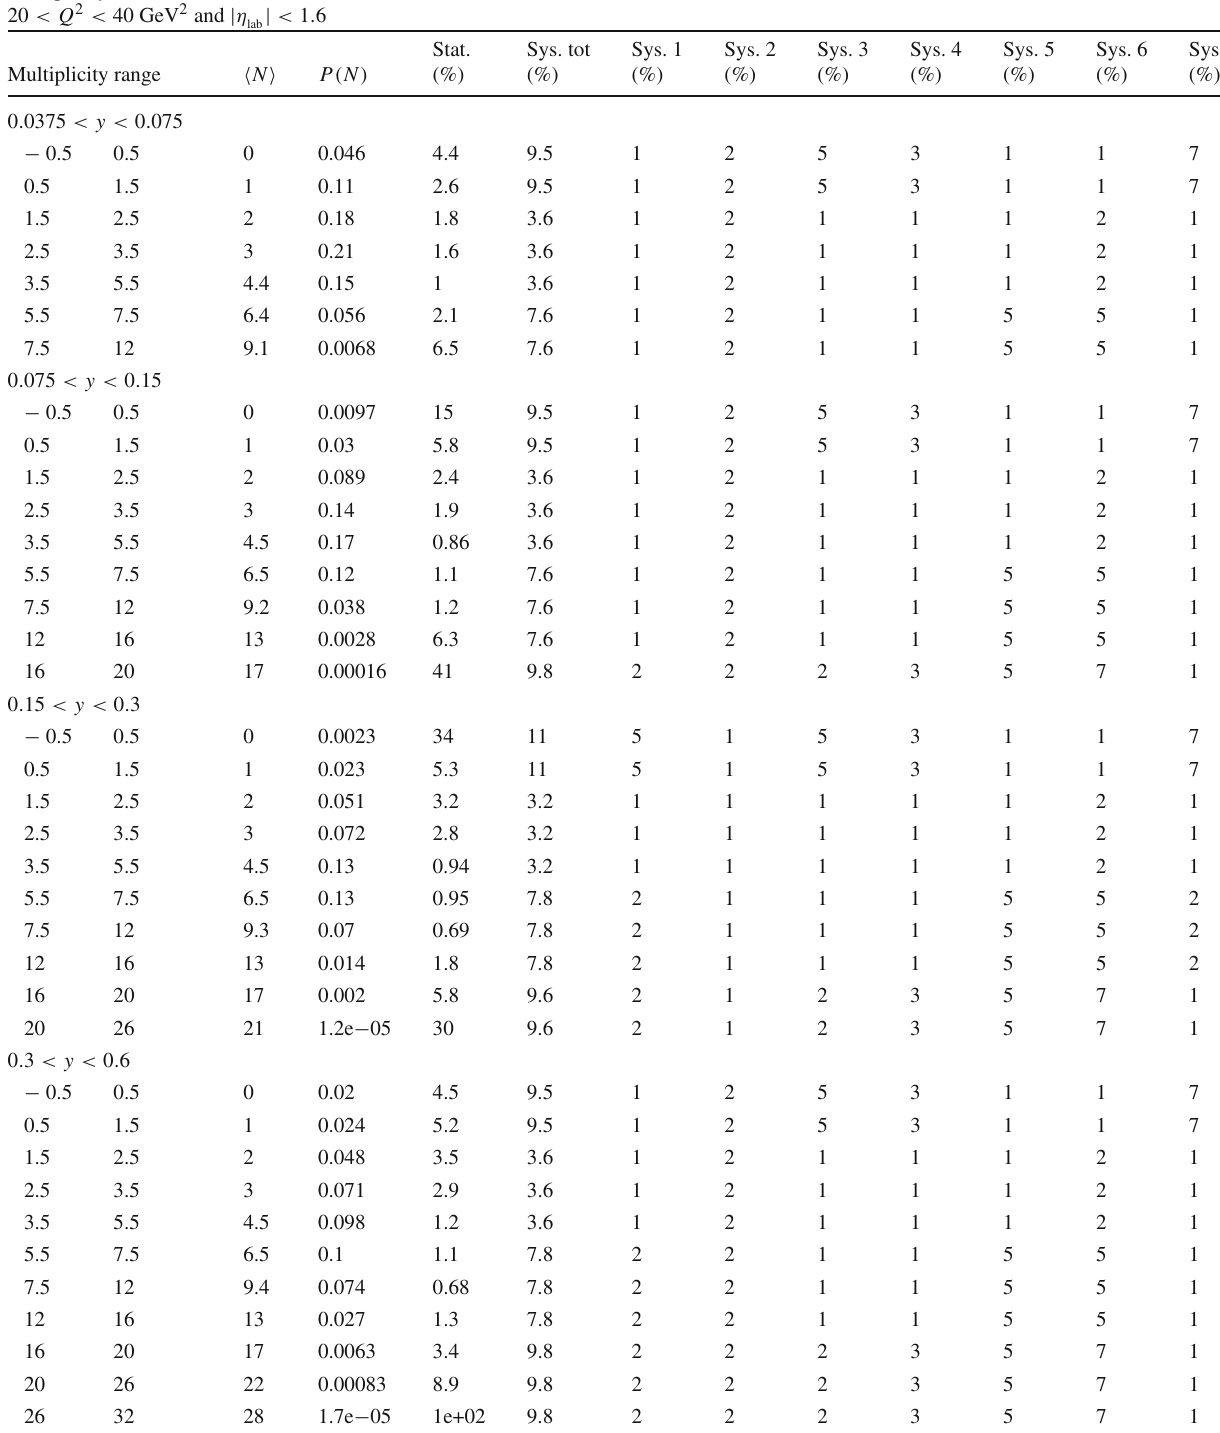
Table 11 Charged particle multiplicity distributions P ( N ) measured √ s = 319GeV with in the ranges of photon virtual- in ep DIS at ity 20 < Q 2 < 40 GeV 2 and charged particle pseudorapidity range Multiplicity distributions in DIS | < 1 . 20 < Q 2 < 40 GeV 2 and | η lab